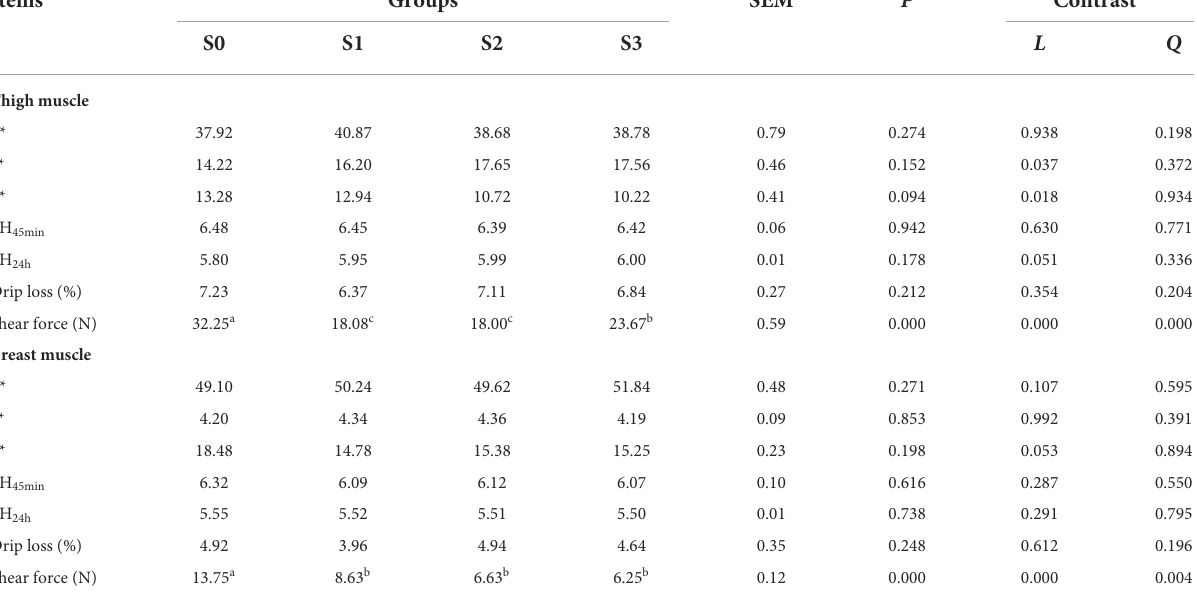
TABLE 4 Effects of BMFA on meat quality of